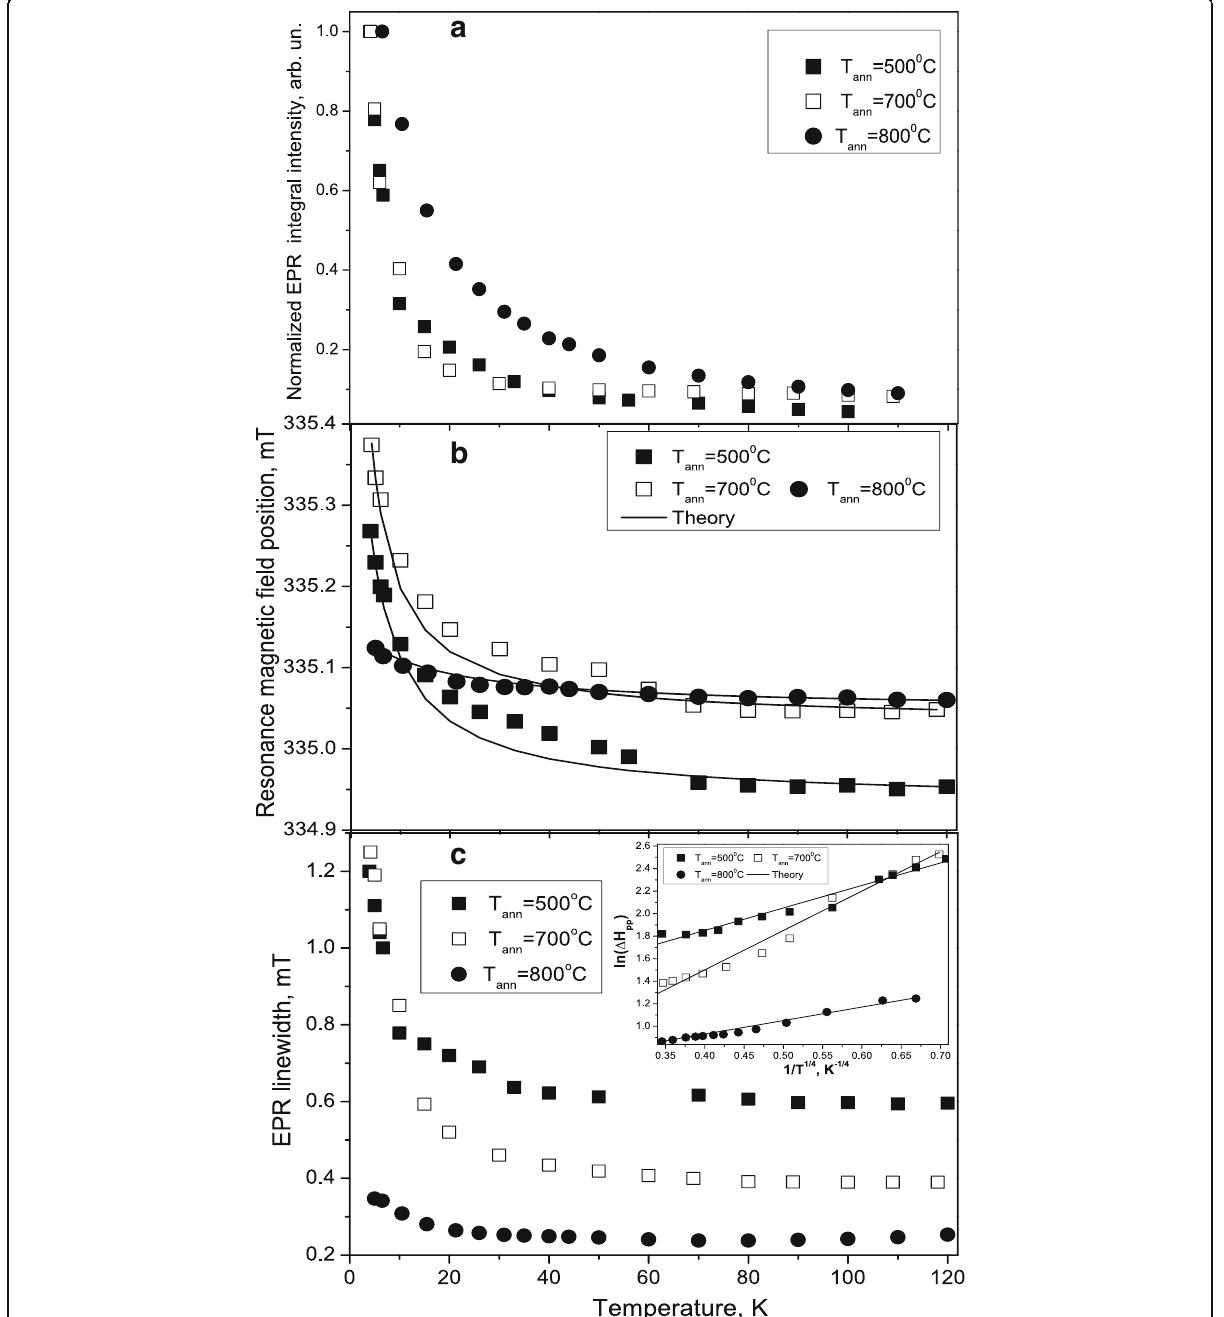
Fig. 5 The temperature dependence of resonance magnetic field position ( a ), EPR signal integral intensity ( b ) and EPR linewidth ( c ) for CRR measured in SiO 2 :C samples annealed at 500, 700, and 800